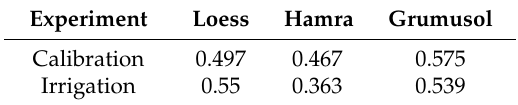
Table 2. Soil porosity (m 3 /m 3 ) measured in laboratory experiments for all